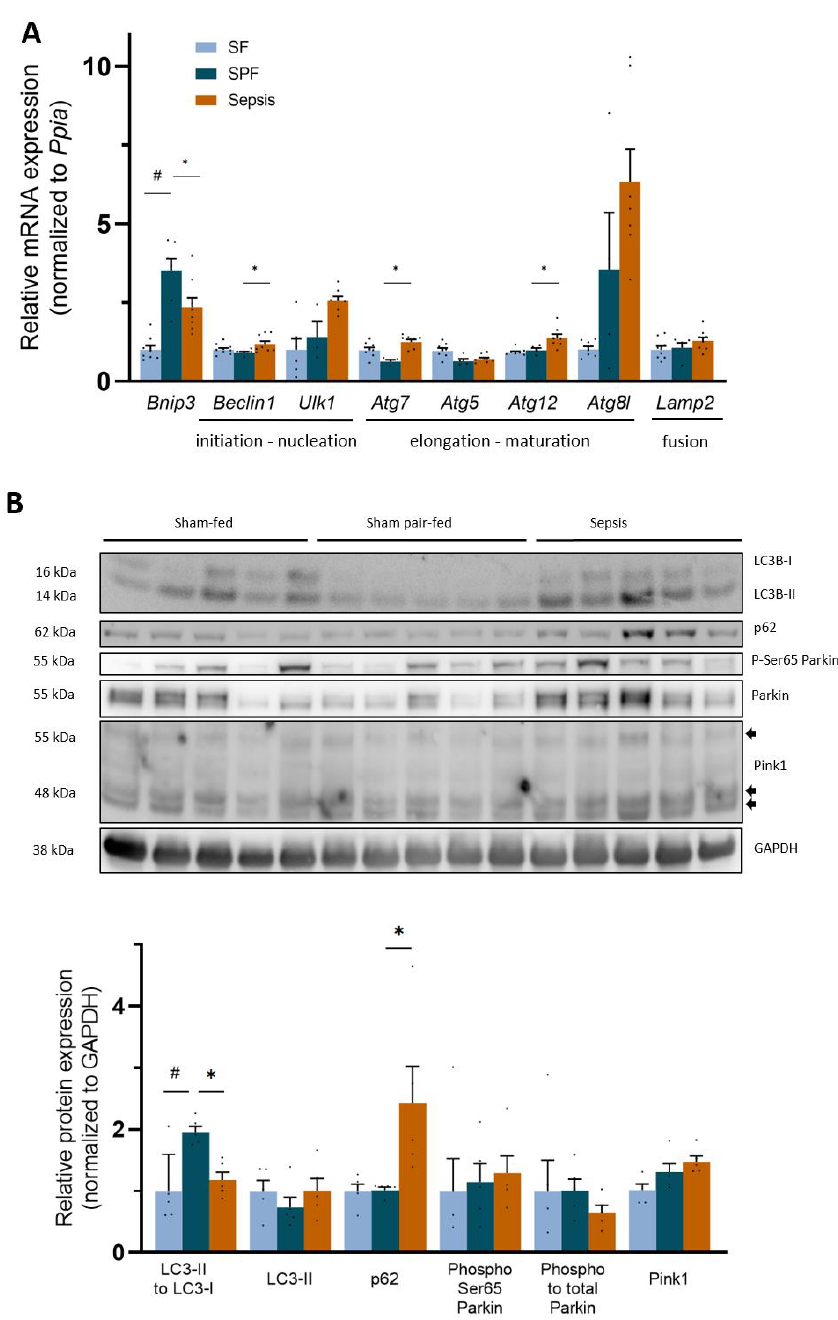
Figure 7. Sepsis-like energy deficit resulted in different autophagy signaling compared with sepsis. ( A ) mRNA expression of the key mito- and autophagy actor Bnip3 increased threefold in the SPF group compared with the Sham-fed (SF) group and was lower in the Sepsis group than the SPF group. Atg7 , Atg12 , and Beclin1 increased in Sepsis mice compared with SPF mice, while Ulk1 , Atg5 , Atg8l , and Lamp2 were not different between groups. ( B ) Protein expression of the main mito- and autophagy actors: relative ratio of LC3B-II:LC3B-I decreased in Sepsis mice compared with Sham pair-fed (SPF) mice, while p62 increased. LC3B-II, Ser65 phospho-Parkin, ratio of phospho: total Parkin, Pink1, Mfn2, and Drp1 did not differ between groups. Light-blue bars for SF mice, dark-blue bars for SPF mice, and orange bars for Sepsis mice (n = 5–8 per group). Arrows indicate different forms of Pink1. Data expressed as means with SEM and compared using a Kruskal–Wallis test with post hoc Dunn’s test. # SPF vs. SF and * Sepsis vs. SPF. * p < 0.05, # p <